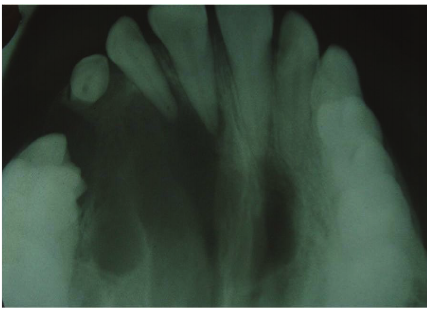
Figure 1: Profile photograph of the patient.